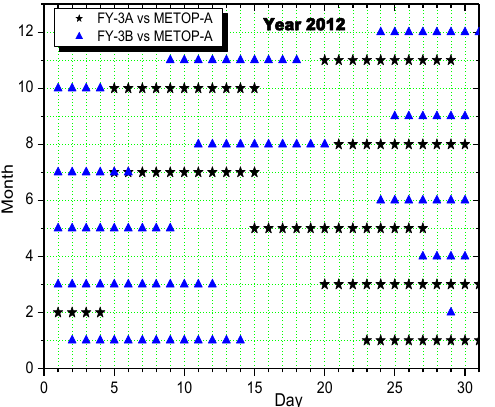
Figure 2. Temporal distributions of cross points between FY-3A&B and METOP-A nadir tracks during 2012. The difference in overpass time is within 10 min.